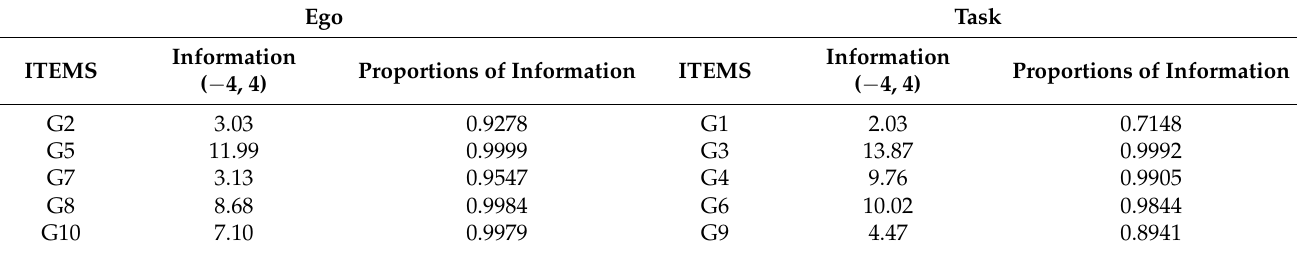
Figure 3. Information curve for the task subscale of the GOEM scale. Table 4. The value of the information function for individual